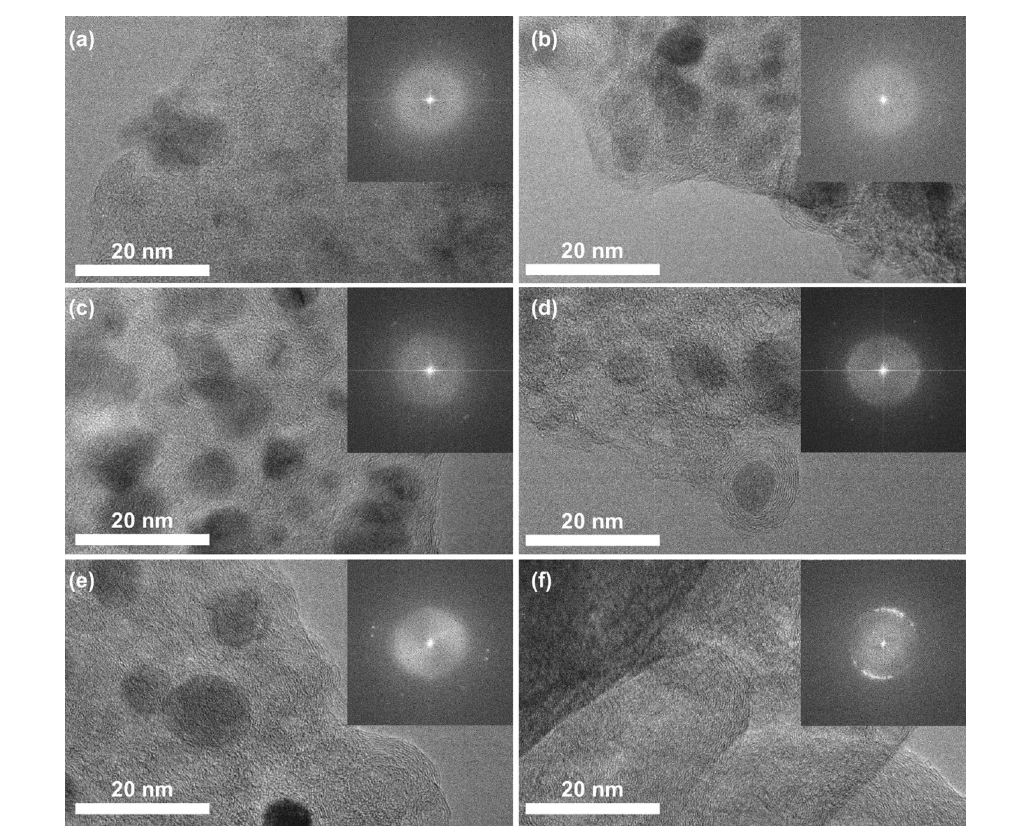
Fig. 5 High-magnification HR-TEM images of the samples at different carbonization temperature: a 500 °C, b 600 °C, c 700 °C, d 800 °C, e 900 °C, and f 1000 °C (Insets are their corresponding SAED